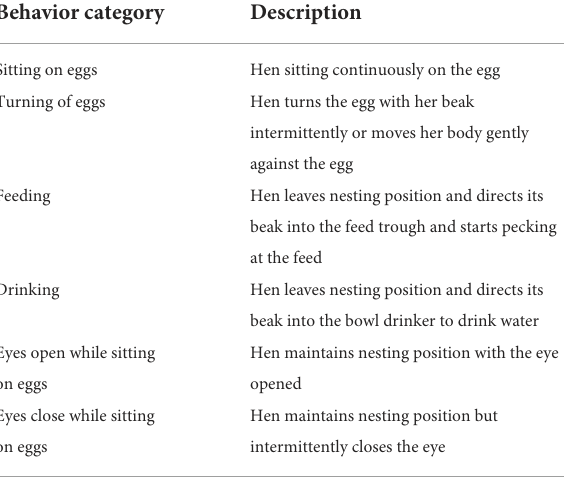
TABLE 1 Behavioral categories and